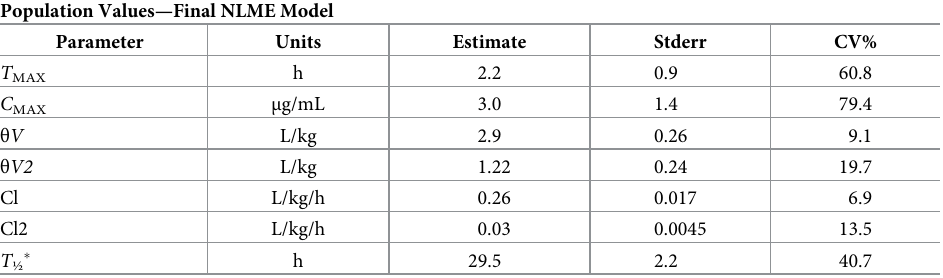
Table 2. Population pharmacokinetic parameters for danofloxacin in 3-week old vs. 6-month old calves with respiratory disease. Population Values—Final NLME Model Parameter Units Estimate Stderr T MAX 60.8 C MAX μ g/mL 79.4 θ V L/kg 0.24 19.7 Cl L/kg/h 0.26 0.017 6.9 Cl2 L/kg/h 0.03 13.5 h 29.5 2.2 40.7 Population values from NLME model and median and range of PK parameters from compartmental analysis after single S.C. injection of 8 mg/kg danofloxacin in 3-week-old vs. 6-month-old calves with induced respiratory disease with P . multocida . � Indicates significantly different by t -test ( P <